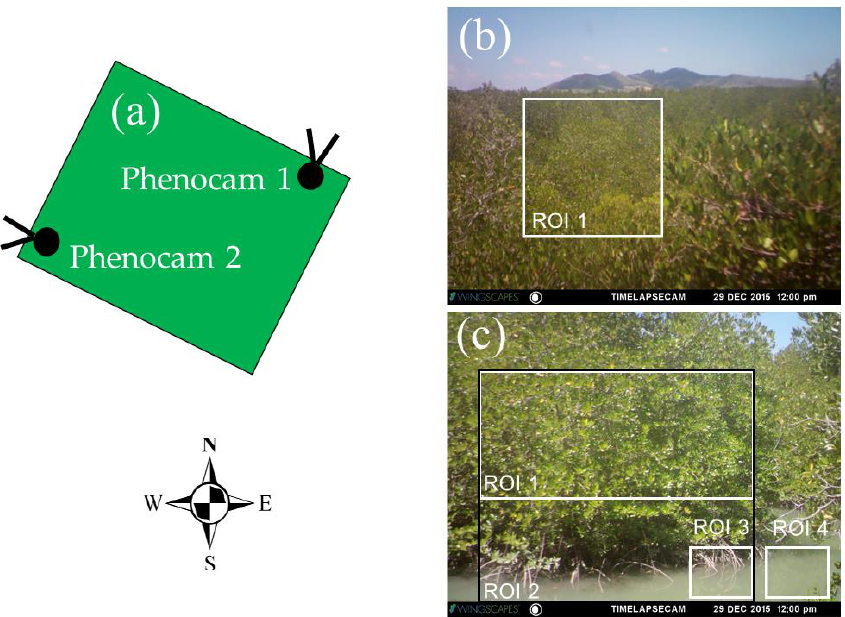
Figure 2. Fields of view and orientations of the two phenocams installed in the mangrove forest tower enclosure, which protected the phenocams. ( a ) The green square represents the top view of mangrove tower roof, with the viewing directions for ( b ) phenocam-1 (north facing) and ( c ) phenocam-2 (west facing) both showing the region of interest (ROI) of the mangrove forest area (ROI 1, white rectangle), as well as the combined mangrove–water canopy (ROI 2, black rectangle), the area where water level estimates were made (ROI 3), and the water background (ROI 4) from phenocam-2